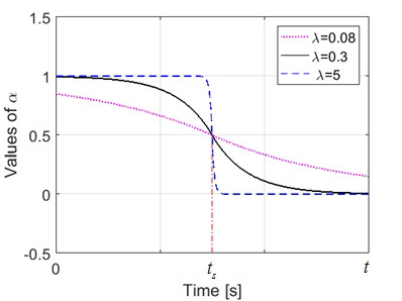
Figure 2. Nonlinear function of α